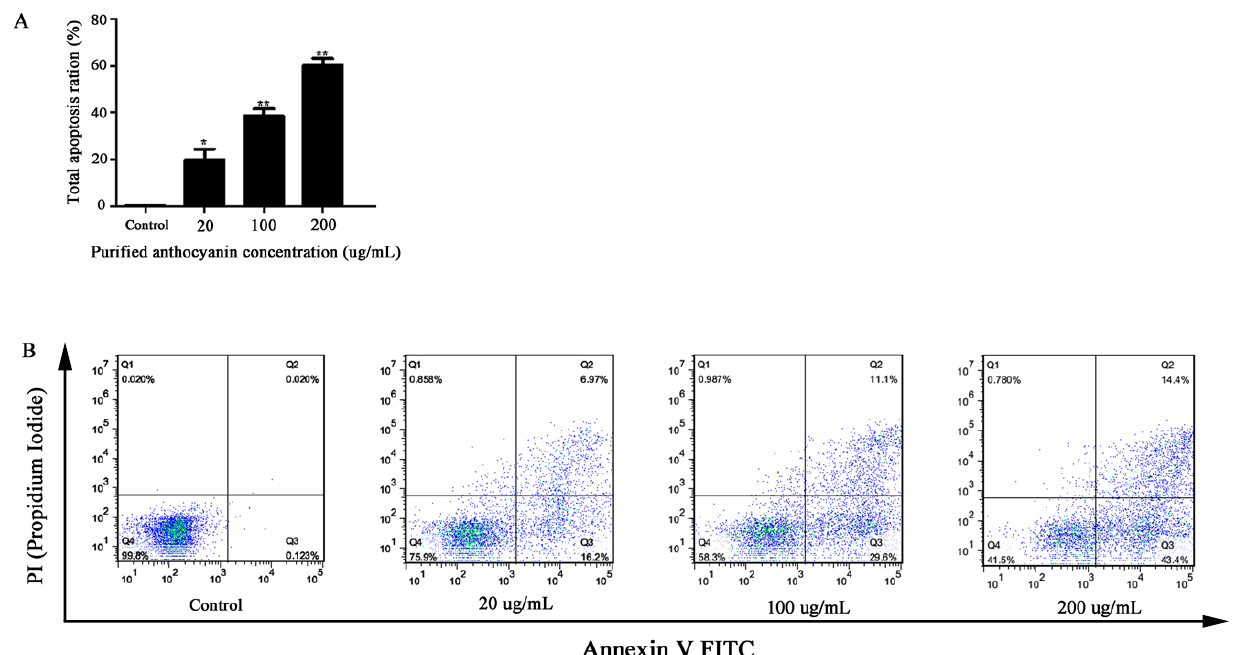
Figure 7. Apoptosis effects of different concentrations of the enriched anthocyanins fraction on BGC-803 cells for 48 h (0, 20, 100, 200 µ g/mL). ( A ): Apoptosis results of the statistical analysis of flow cytometry detection; *: Significant difference ( p < 0.05); ** Highly significant difference ( p < 0.01); ( B ): The treated cells were subjected to flow cytometric analysis after PI (Propidium Iodide) and Annexin V staining.